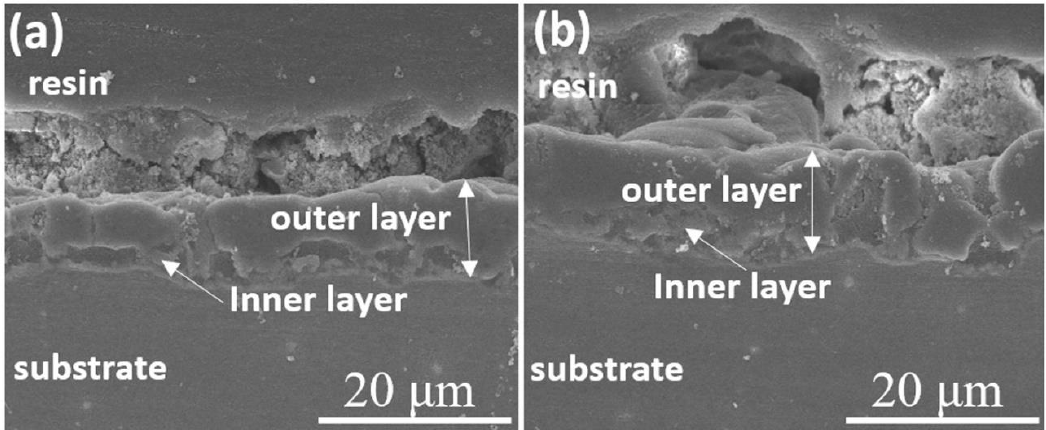
Figure 4. Cross-sectional morphologies of the titanium samples treated by PEO in different electrolytes ( a ) Bath A and ( b ) Bath B.